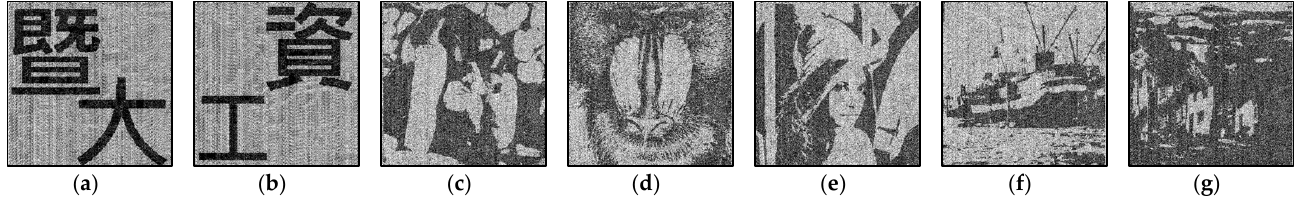
Figure 8. Experimental results by Method 2 for (5, 5) with 𝑝 = 45, 𝛾 = 0.5 . ( a , b ) Restored images R 0 , R 1 ( c )–( g ) Shares M 0 , …, M 4 .